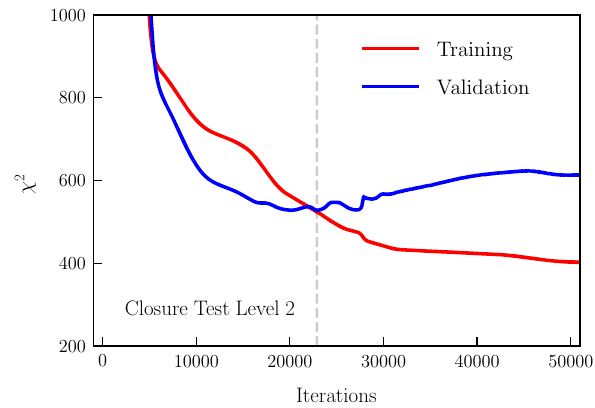
Fig. 12 Schematic representation of different types of nuclear modifi- cations that are expected to arise in the nPDFs, f ( N / A ) , when presented as ratios to their free-nucleon counterparts, R f = f ( N / A ) / f ( N )